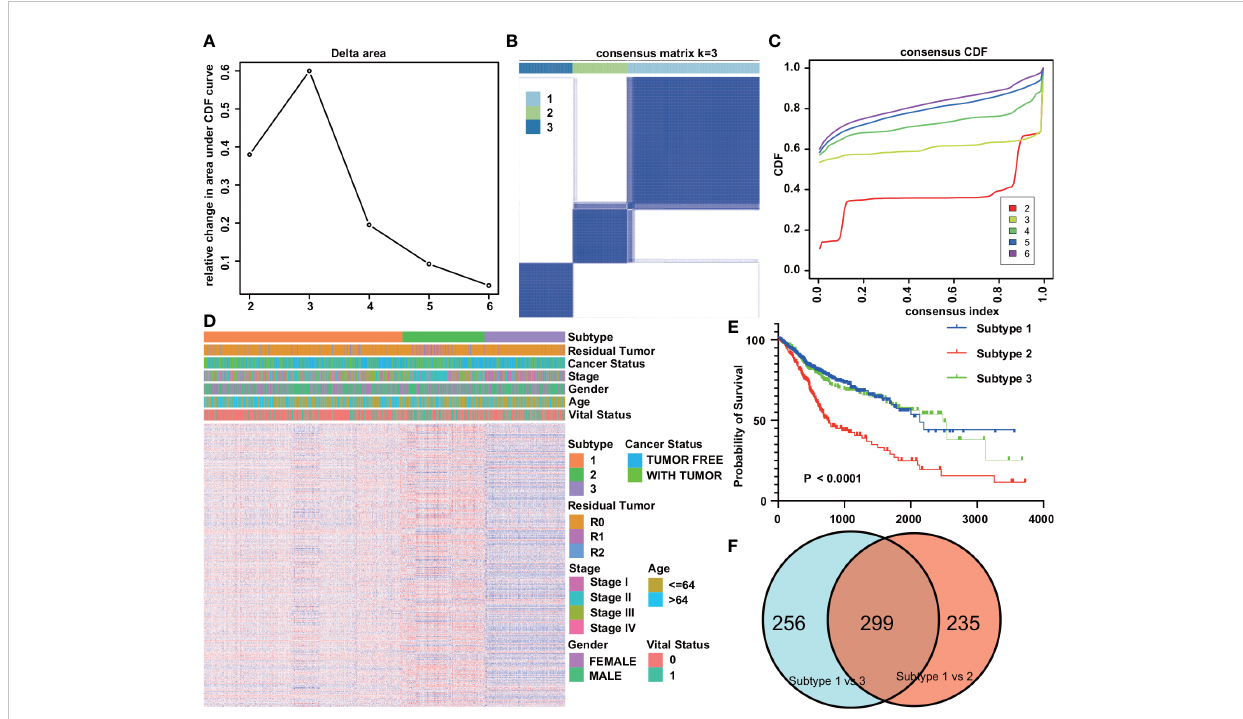
FIGURE 3 Tumor subtypes based on immunologic gene sets. (A) Delta area plot showed the relative change in area under the CDF curve. (B) Consensus matrices of the DST cohort for k=3. (C) Consensus cumulative distribution functions (CDF) of the consensus matrix for each k value (indicated by colors). (D) Gene set heatmap and clinicopathological features of the three subtypes identi fi ed. (E) Kaplan-Meier overall survival curves for the three subtypes. (F) Venn plot of the results of the analysis of differences between different